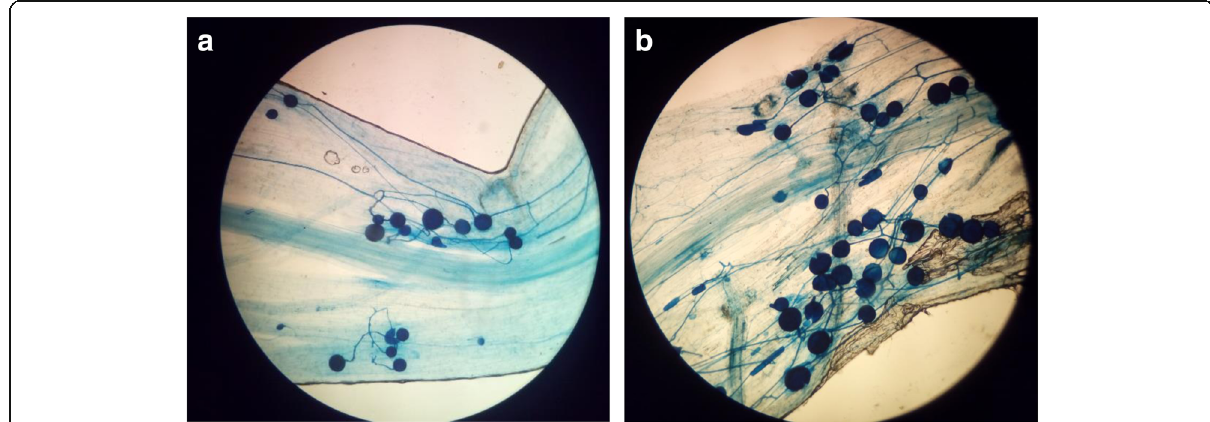
Fig. 1 Association of P. indica with rice roots. a Established symbiosis after 4 days of germination, a network of hyphae and spores is visible within rice roots. b Network of hyphae along with attached spores, observed at the end of